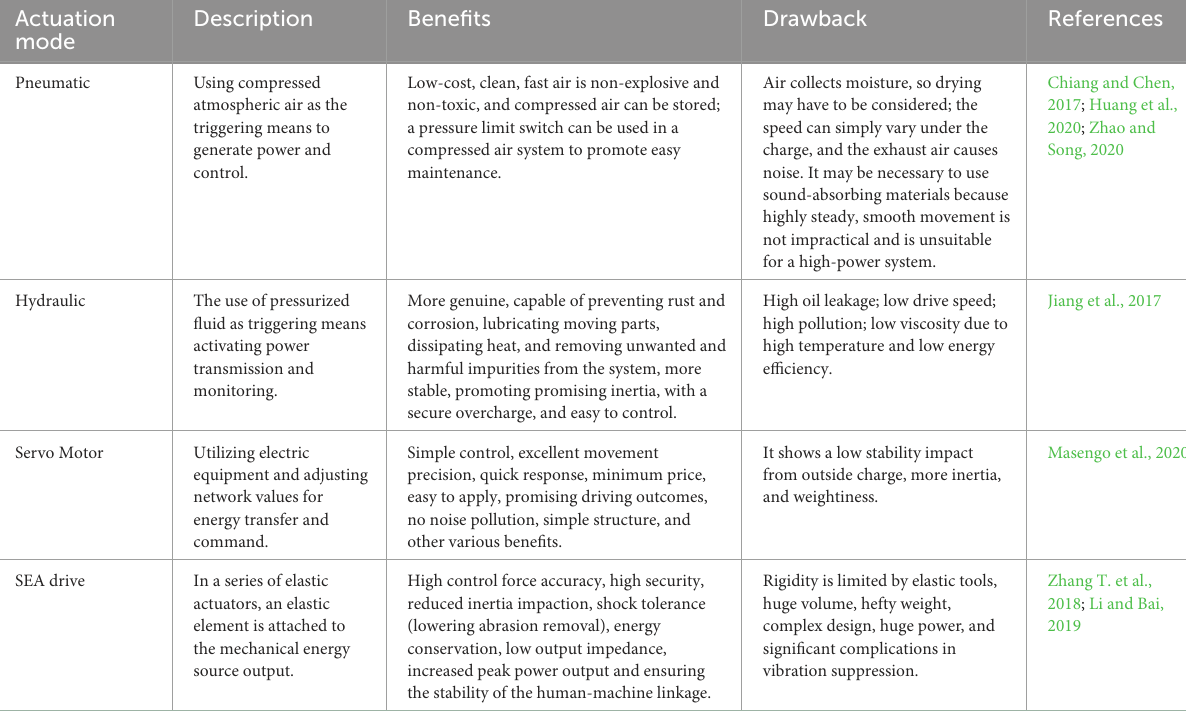
TABLE 1 Summary of different types of actuation